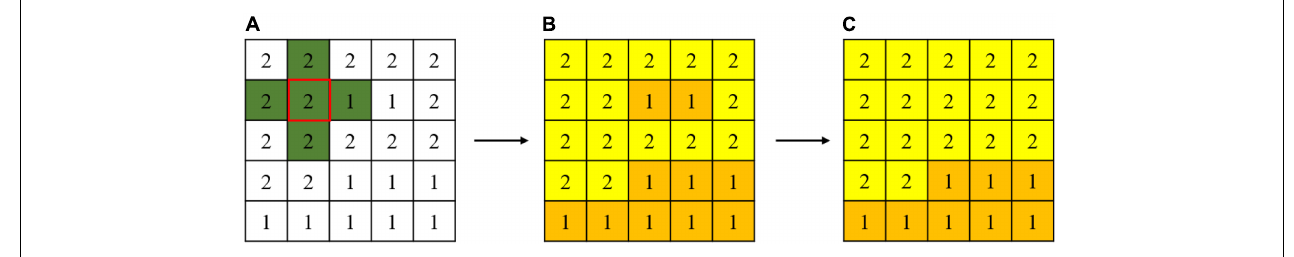
FIGURE 6 | Connected domain calibration process is (A) a sub-image of classification results, (B) the connected domains of different types, and (C) the optimization